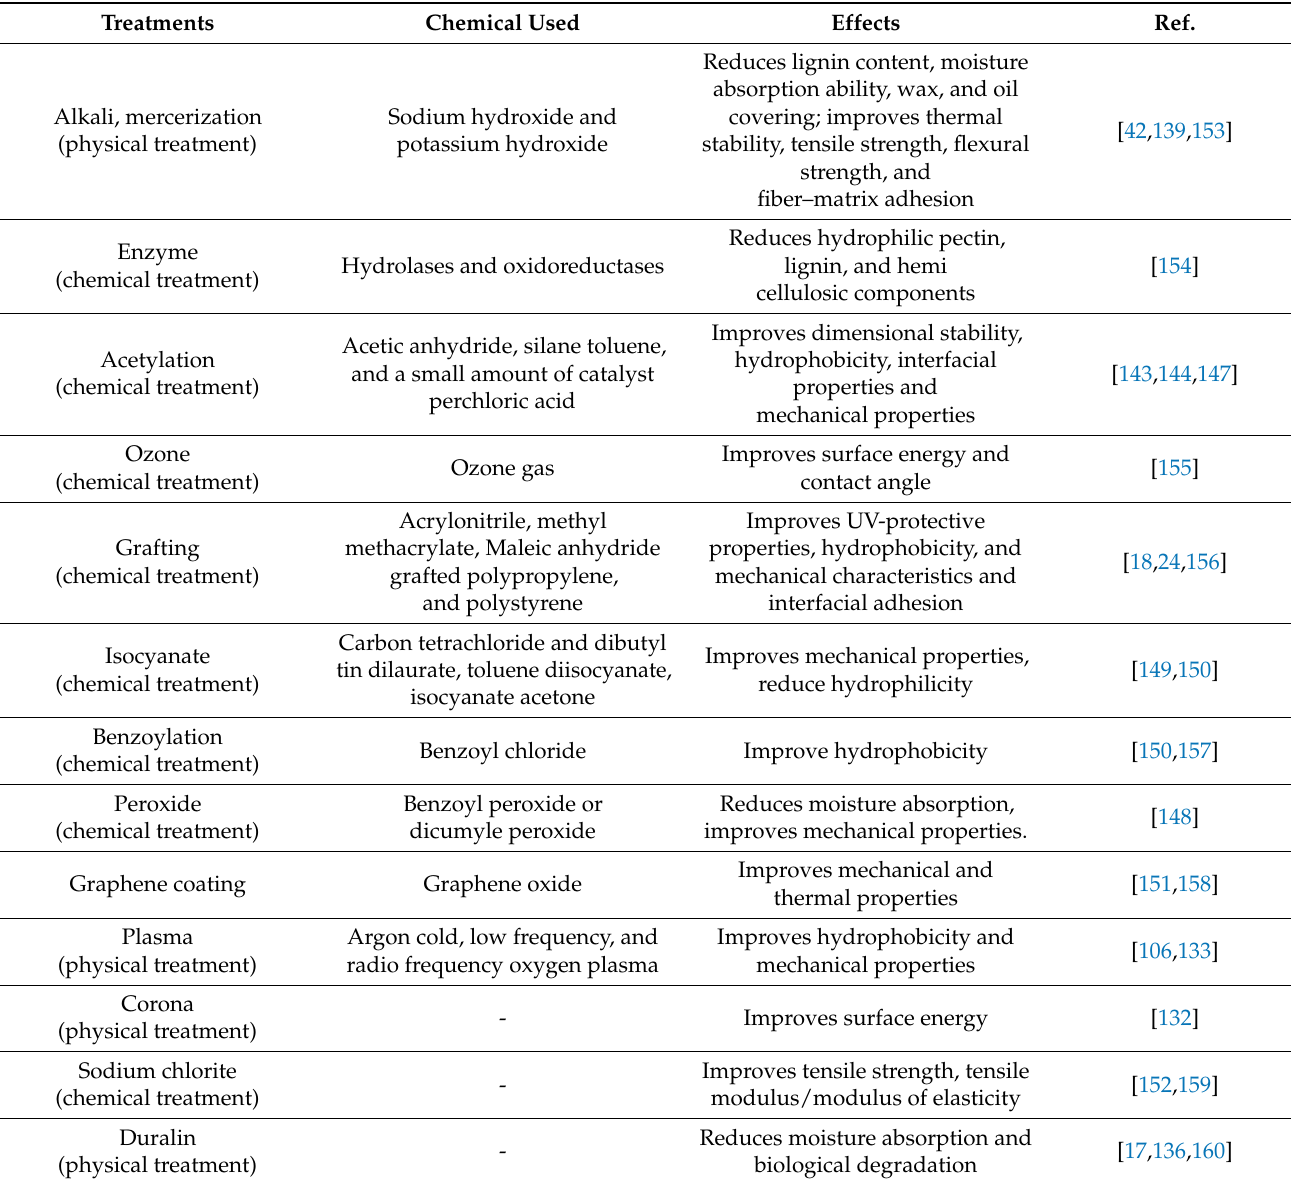
Table 5. Physical and chemical treatments of natural